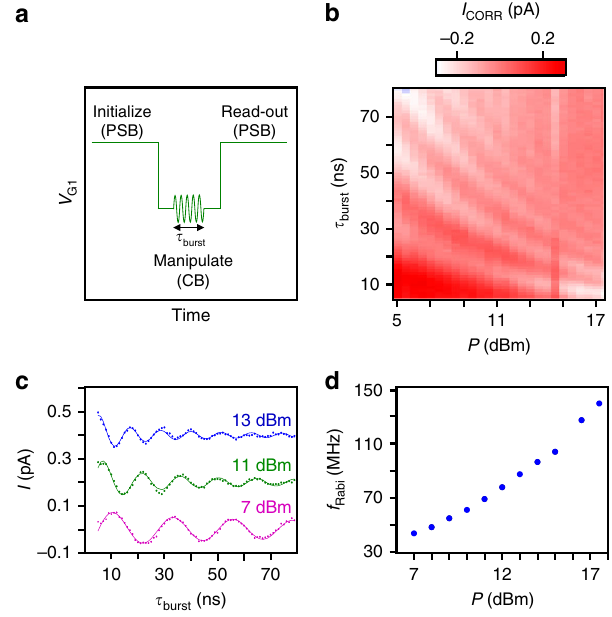
Fig. 5 Coherent spin oscillations. a Voltage signal applied to G1 for performing the Rabi experiment. The square pulse shifts the qubit between PSB and Coulomb blockade (CB), lasting for 210 and 100 ns, respectively. The applied RF burst rotates the initialized spin-down vector for an angle proportional to its duration τ burst and the square root of power b Corrected current I CORR versus τ burst and P for an out-of-plane magnetic fi eld of 127 mT and an RF frequency of 5.966 GHz for device C after thermal cycling, showing Rabi oscillations. The current data has been corrected by removing the average column and row values from the corresponding data points. c Current I CORR vs τ burst traces for P = 7, 11 and 13 dBm. For clarity, the traces for 11 and 13 dBm are shifted by 200 and 400 fA, respectively. The Rabi frequencies were extracted by fi tting the raw data to